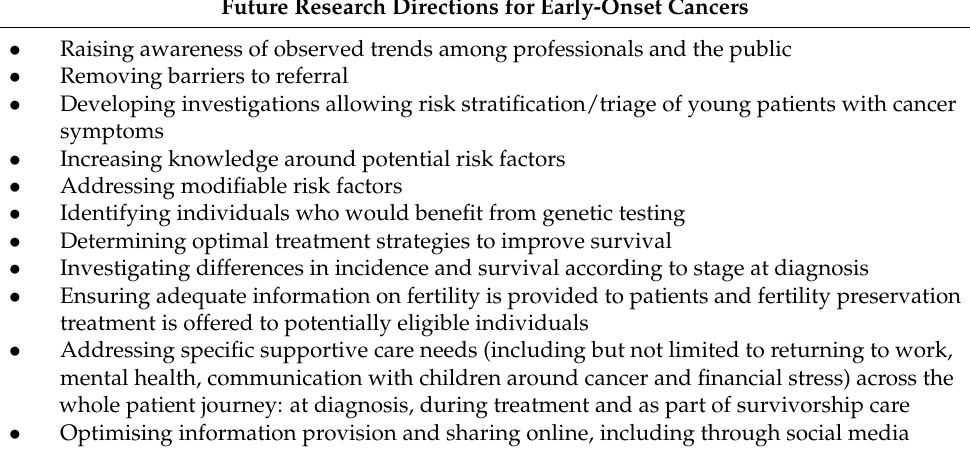
Table 1. Summary of future research areas for early-onset